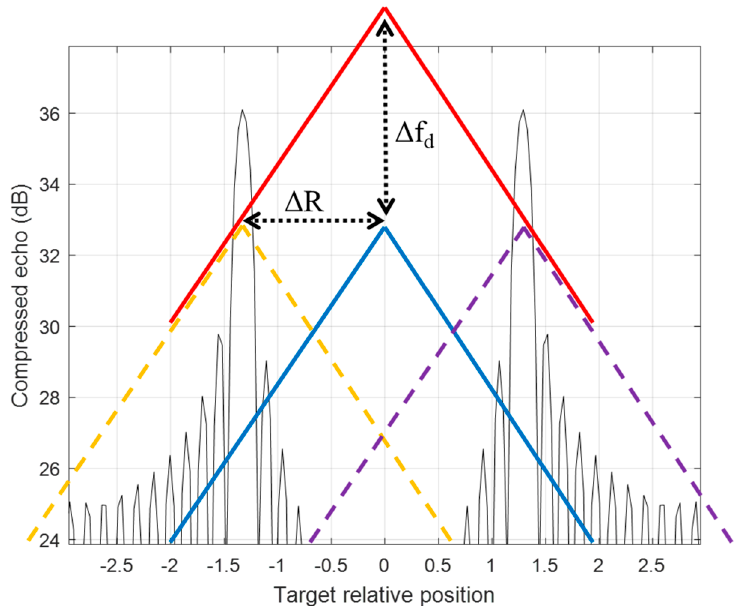
Figure 4. An up-down LFM waveform resolves two detection peaks from a non-stationary target by matched filter detectors.